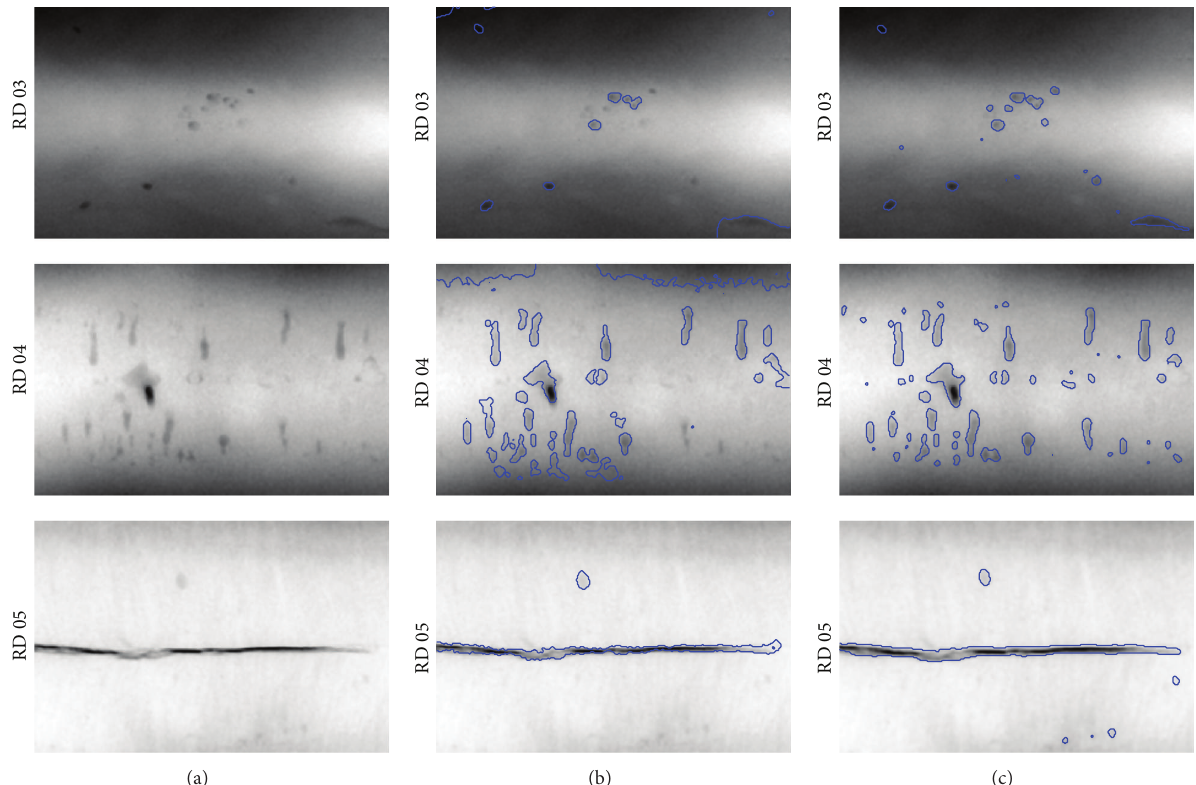
Figure 6: Comparative defect detection tests: (a) ROI selected image, (b) result of LIF active contour, and (c) result of the proposed method.